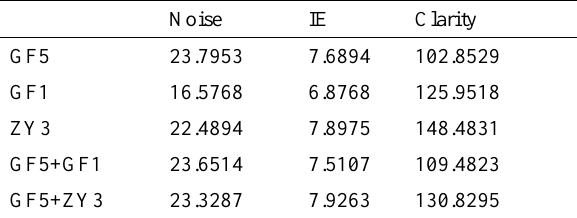
Table 5 . Image quality evaluation before and after